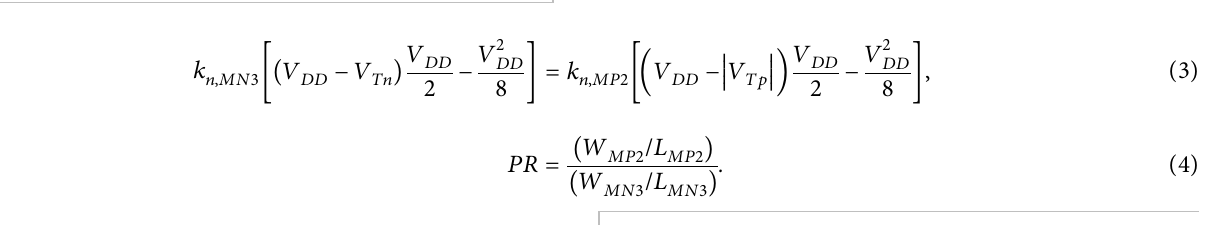
basic rules of RRAM. Each column and row share bit